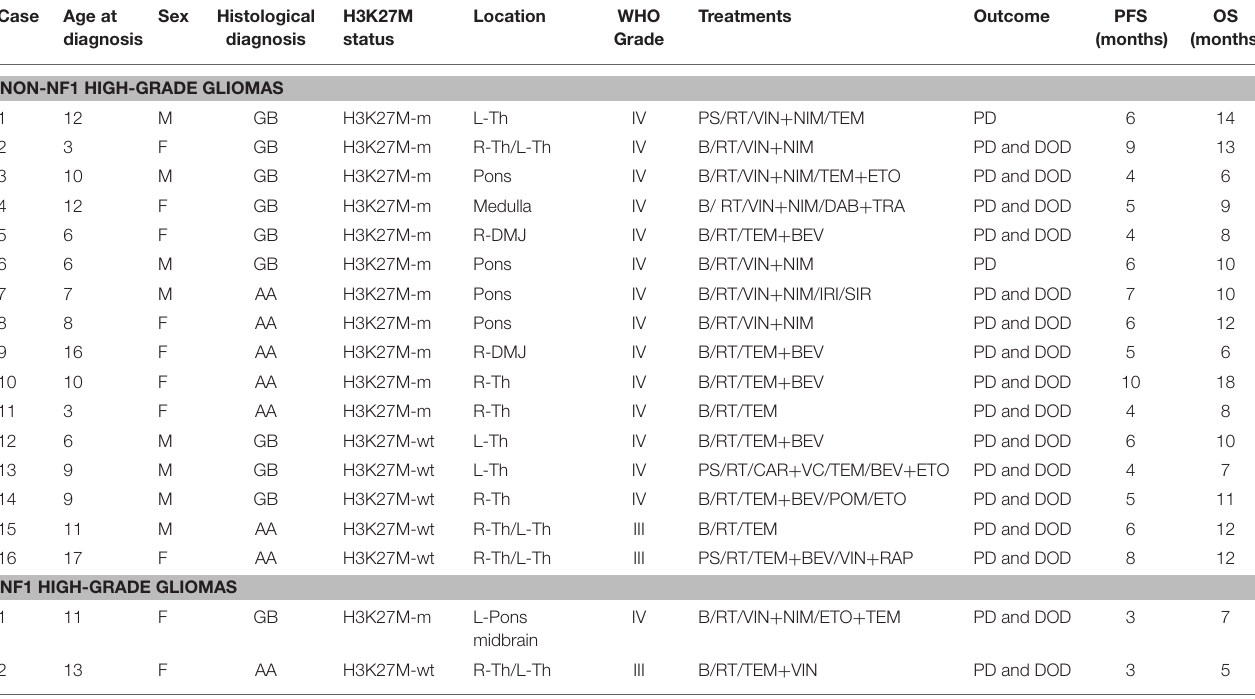
TABLE 1 | Summary of patient characteristics, treatments, and outcome. Case Age at Sex Histological H3K27M Location WHO Treatments Outcome PFS diagnosis diagnosis status Grade